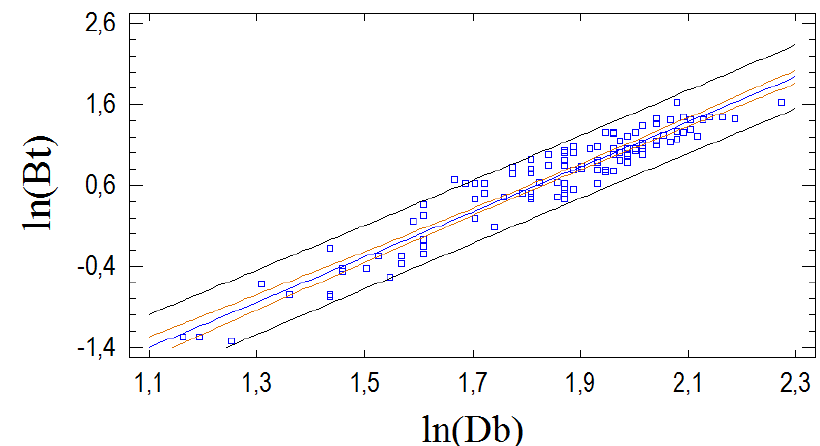
Figure 4. Plot of the fitted model for stem biomass estimation in Paulownia ; the selected allometric model correspond to Equation (1) log-transformed: ln( Bt ) = − 4.462 + 2.784ln( Db ); N =